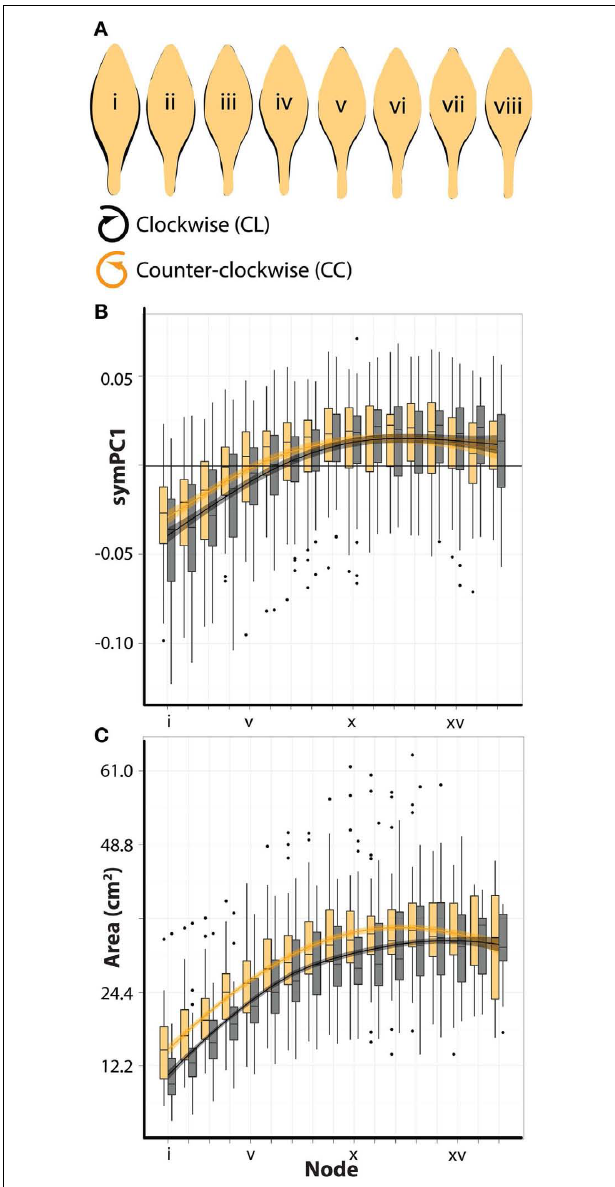
FIGURE 6 | Counter-clockwise plants produce larger leaves with more developed shape characteristics. (A) Shown are juxtaposed mean outlines of abaxial-top leaves arising from clockwise (black, CL) and counter-clockwise (orange, CC) plants for the first eight nodes from the apex. Note that leaves arising from CC plants have more defined petioles and the distribution of their laminar outgrowth is shifted distally compared to leaves from CL plants – characteristics typical of more developed leaves found farther in the series (see Figure 2A ). (B) symPC1 values for abaxial-top leaves separated by leaves arising from clockwise (black, CL) and counter-clockwise (orange, CC) plants. Superimposed upon barplots are loess regression lines with standard error bands. x -axis shows node position (lower values closer to the apex). CL symPC1 values are shifted right relative to CC values across the leaf series, suggesting a developmental delay. (C) Similar to (B), but showing the overall blade area (cm 2 ) of leaves. Note again that CL leaves are shifted right relative to CC leaves, suggesting a developmental delay.